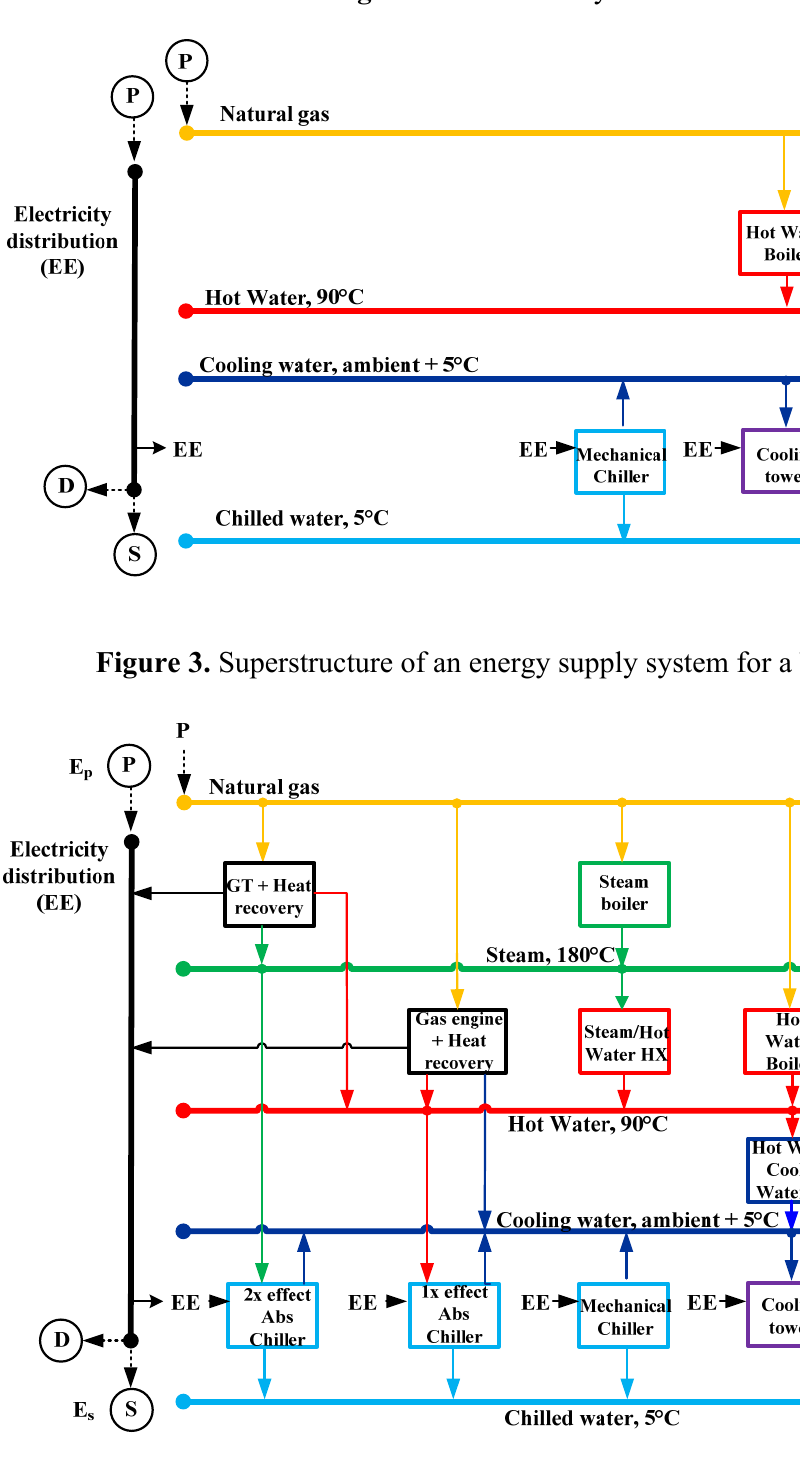
Figure 2. Reference system.